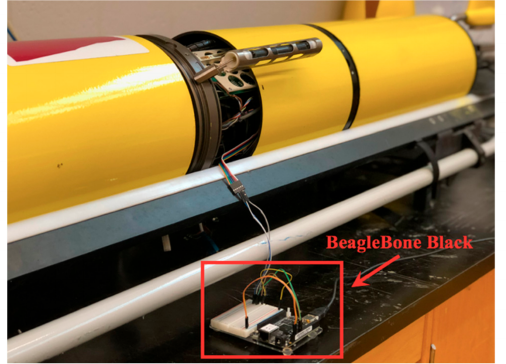
Figure 5. Connecting BeagleBone Black to the Slocum G1 glider to test the performance of the backseat